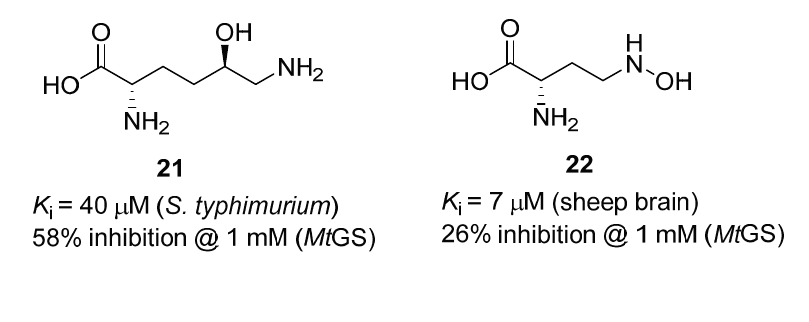
Figure 7. Glutamate analogues found to weakly inhibit Mt GS